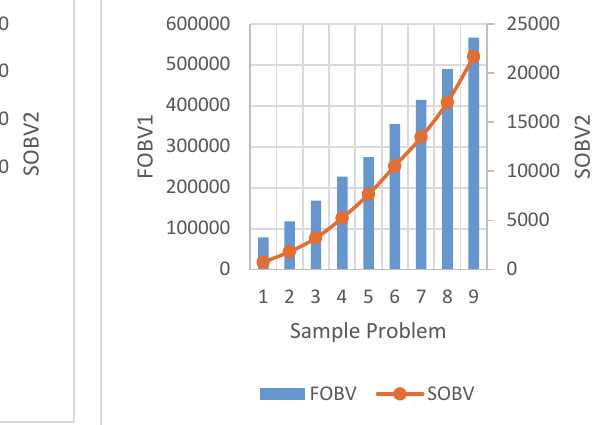
Fig. 15 . Changes of the first and second objective function in different sample problems by MOALO